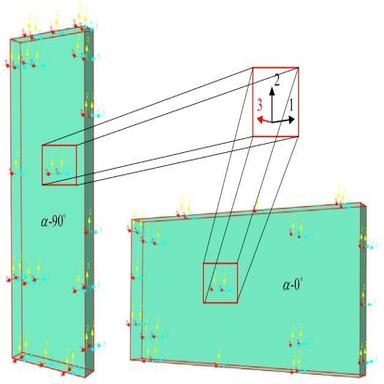
Plates with different material directions, (a) plates on α plane, (b) plates on β plane, (c) plates on λ plane.